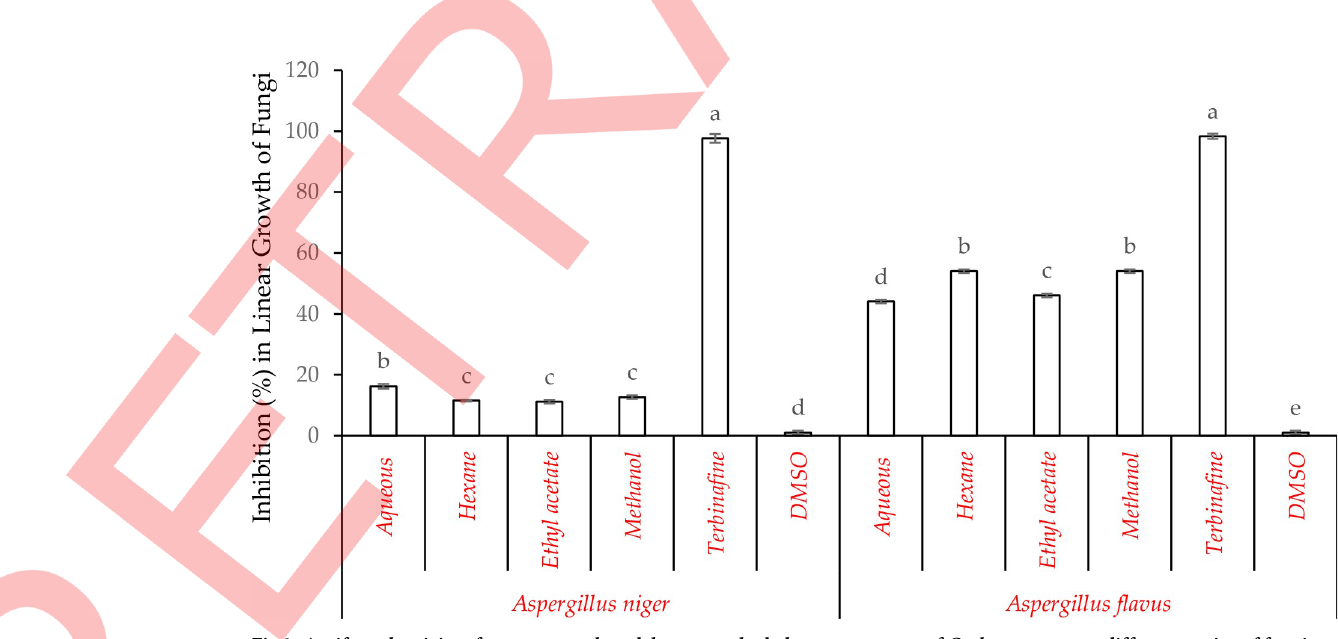
2, 2-azinobis (3-ethylbenzo-thiazoline-6-sulfonate) ABTS � scavenging ability Percent scavenging effect of ABTS in aqueous, methanolic, ethyl acetate, and n- hexane extracts of C . glaucum is shown in Fig 4. The highest antioxidant activity (83%) was recorded for aque- ous extract at 300 μ g/ml. Ethyl acetate and methanol extracts at this concentration also showed high antioxidant activity (82%) next to aqueous extract. The n -hexane extract showed the low- est antioxidant activity (75%) among the four tested extracts.